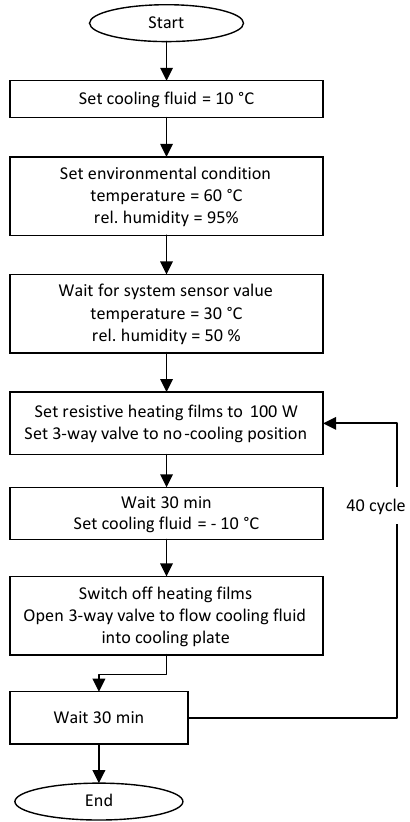
Figure 6. Test profile 2 (for examination of the condensation with a faulty cooling system in harsh environmental conditions).